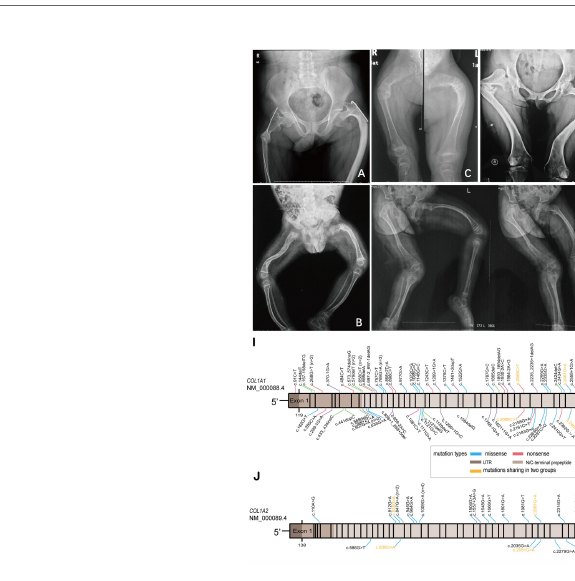
FIGURE 2 | X-ray radiography of the lower extremities of six de novo and two inherited mutation probands with clinical type III, and diagrams showing mutation loci identi fi ed in this study. (A, B) X-ray radiography of the femurs of the probands (p68 and p56) with inherited mutations. (C – H) X-ray radiography of the lower extremities of the probands (P9, P3, P49, P43, P13, and P26, respectively) with de novo mutations. (I) Mutation loci in COL1A1 gene identi fi ed in two groups. (J) Mutation loci in COL1A2 gene identi fi ed in two groups.